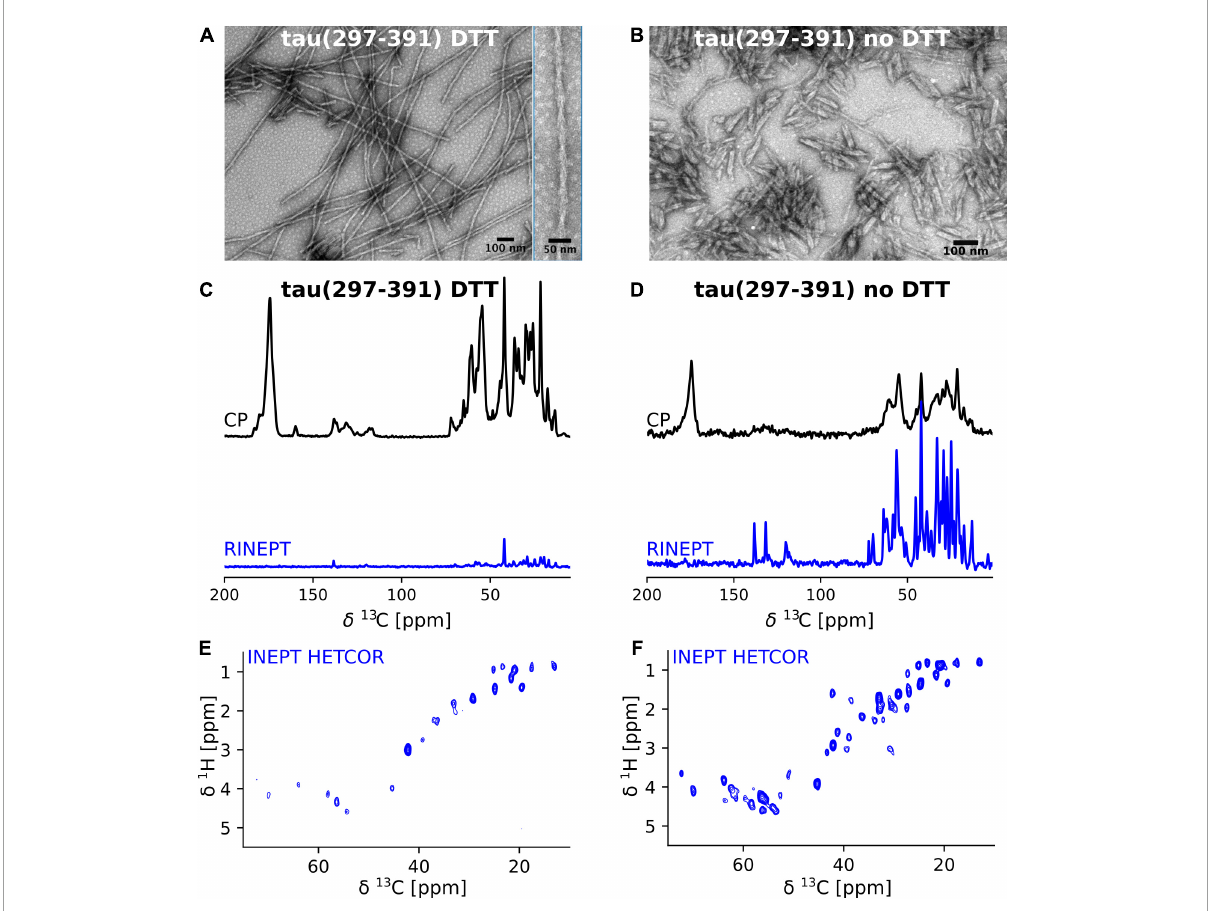
FIGURE1 Tau(297-391) filaments formed in the presence of DTT are much more rigid and ordered compared to filaments formed without DTT. (A,B) EM images of solid-state NMR samples of tau(297-391) filaments formed with and without DTT. (C–F) Solid-state NMR spectra of tau(297-391) filaments formed in the presence (C,E) or absence of DTT (D,F) . (C,D) 1D 13 C spectra recorded using 1 H- 13 C cross polarization (CP, black) and a refocused INEPT transfer (RINEPT, blue) are shown. The CP experiment shows the more static domains of the sample whereas the RINEPT experiment only shows highly dynamic parts of the sample under the conditions used. The strong intensity of the CP spectrum and comparably negligible intensity of the RINEPT spectrum of the filaments made with DTT suggests that the majority of the sample is part of the rigid fibril core. In contrast, the intense RINEPT spectrum of the filaments formed in the absence of DTT suggest that this sample contains a lot of dynamic disorder. (E,F) The 2D 1 H- 13 C INEPT-HETCOR spectra sensitive to dynamic domains confirm this tendency showing many more signals for the sample made in the absence of